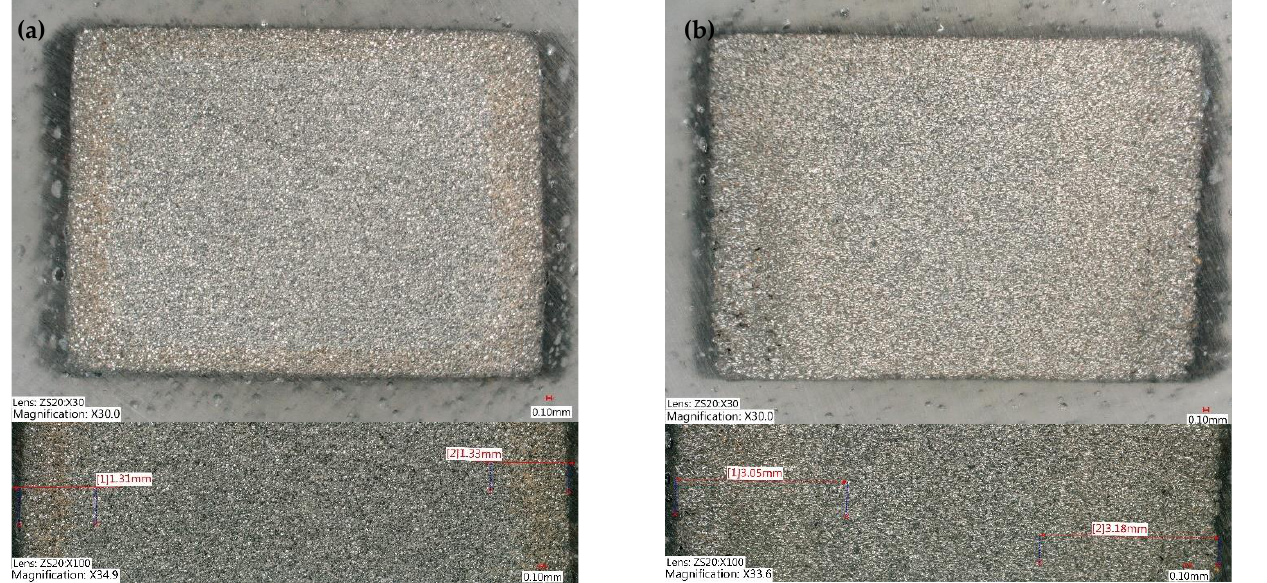
Figure 13. Surface corrosion, cross-section of magnets S90/10 ( a ) and B90/10 ( b ) showing progress of corrosion after immersion in corrosive water at 95 °C for 1000 h.